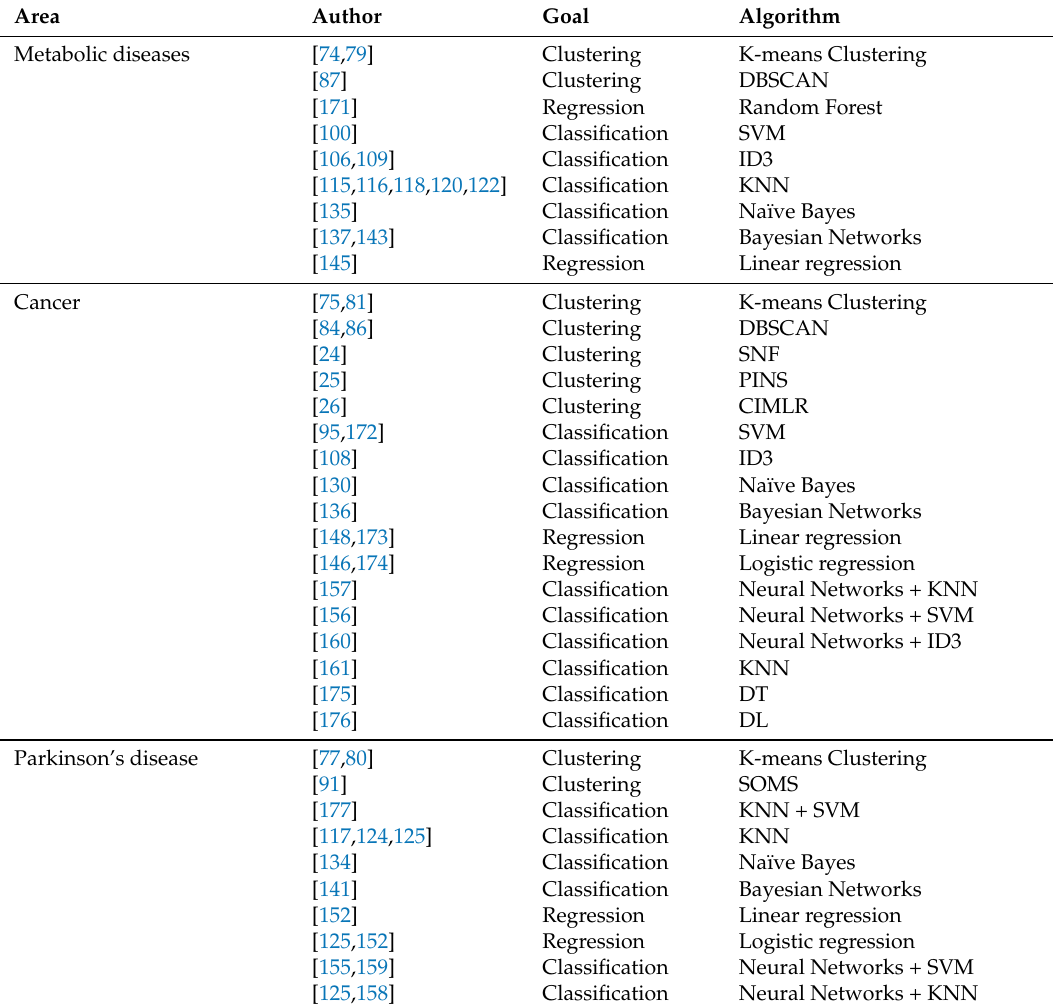
Table 2. Application summary of representative